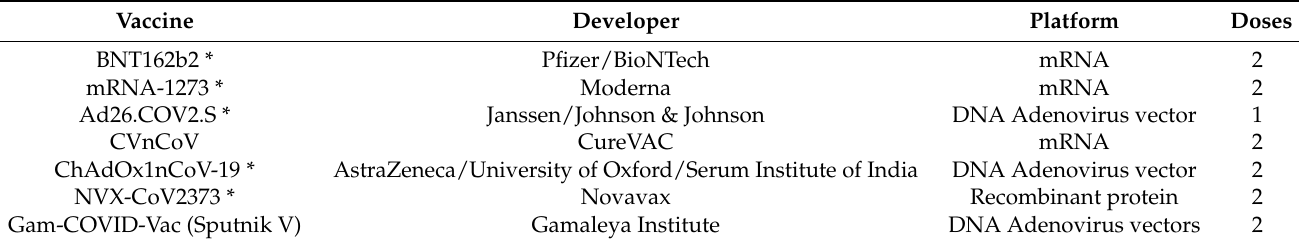
Table 1. Main features of COVID-19